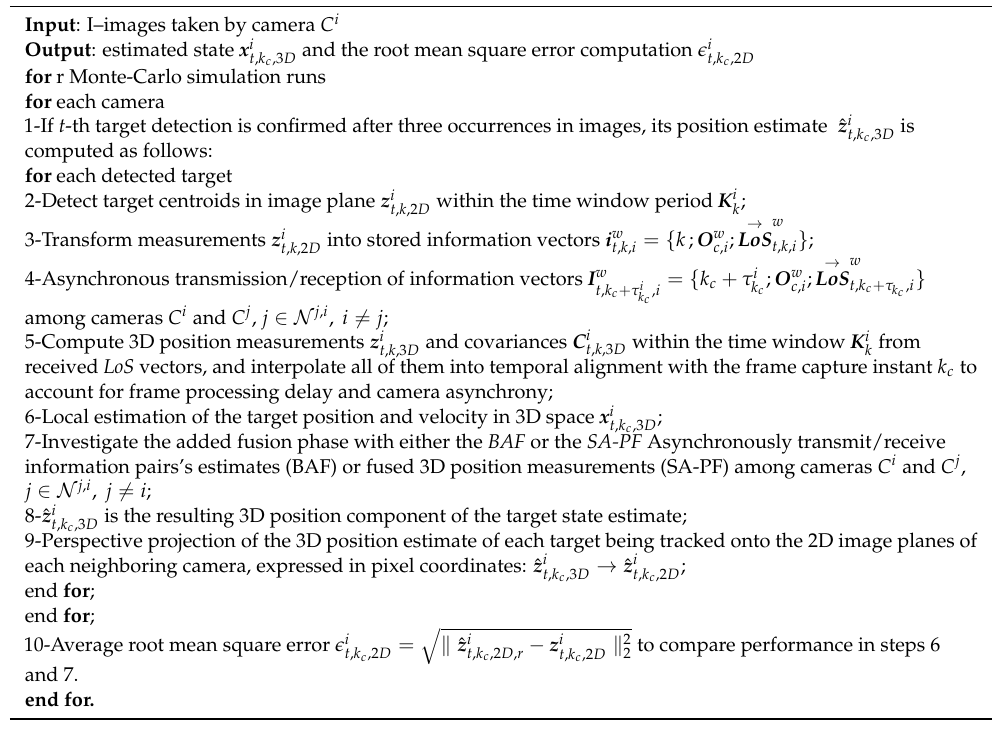
Algorithm1. Algorithm to investigate the effect on target tracking of further fusion other than exchanged LoS vectors and local